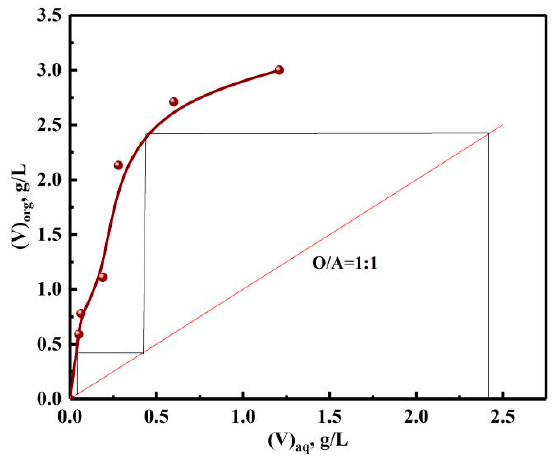
Figure 14. Extraction McCabe–Thiele graph of vanadium.